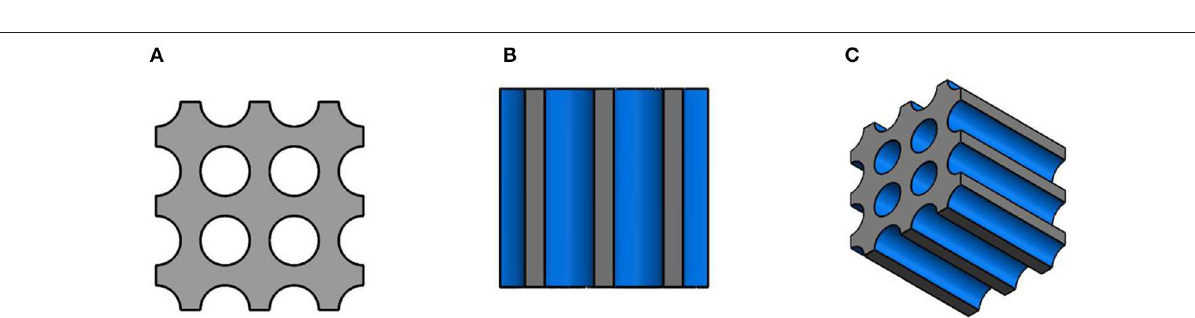
FIGURE 2 | (A) A differential volume of the zoomed-in top/bottom view of the AMR with packed spherical particles. (B) A differential volume of a zoomed-in side view of AMR with packed spherical particles. (C) A differential volume of a zoomed-in isometric view of AMR with packed spherical particles. The solid material is displayed in gray and flow channels are displayed in blue.